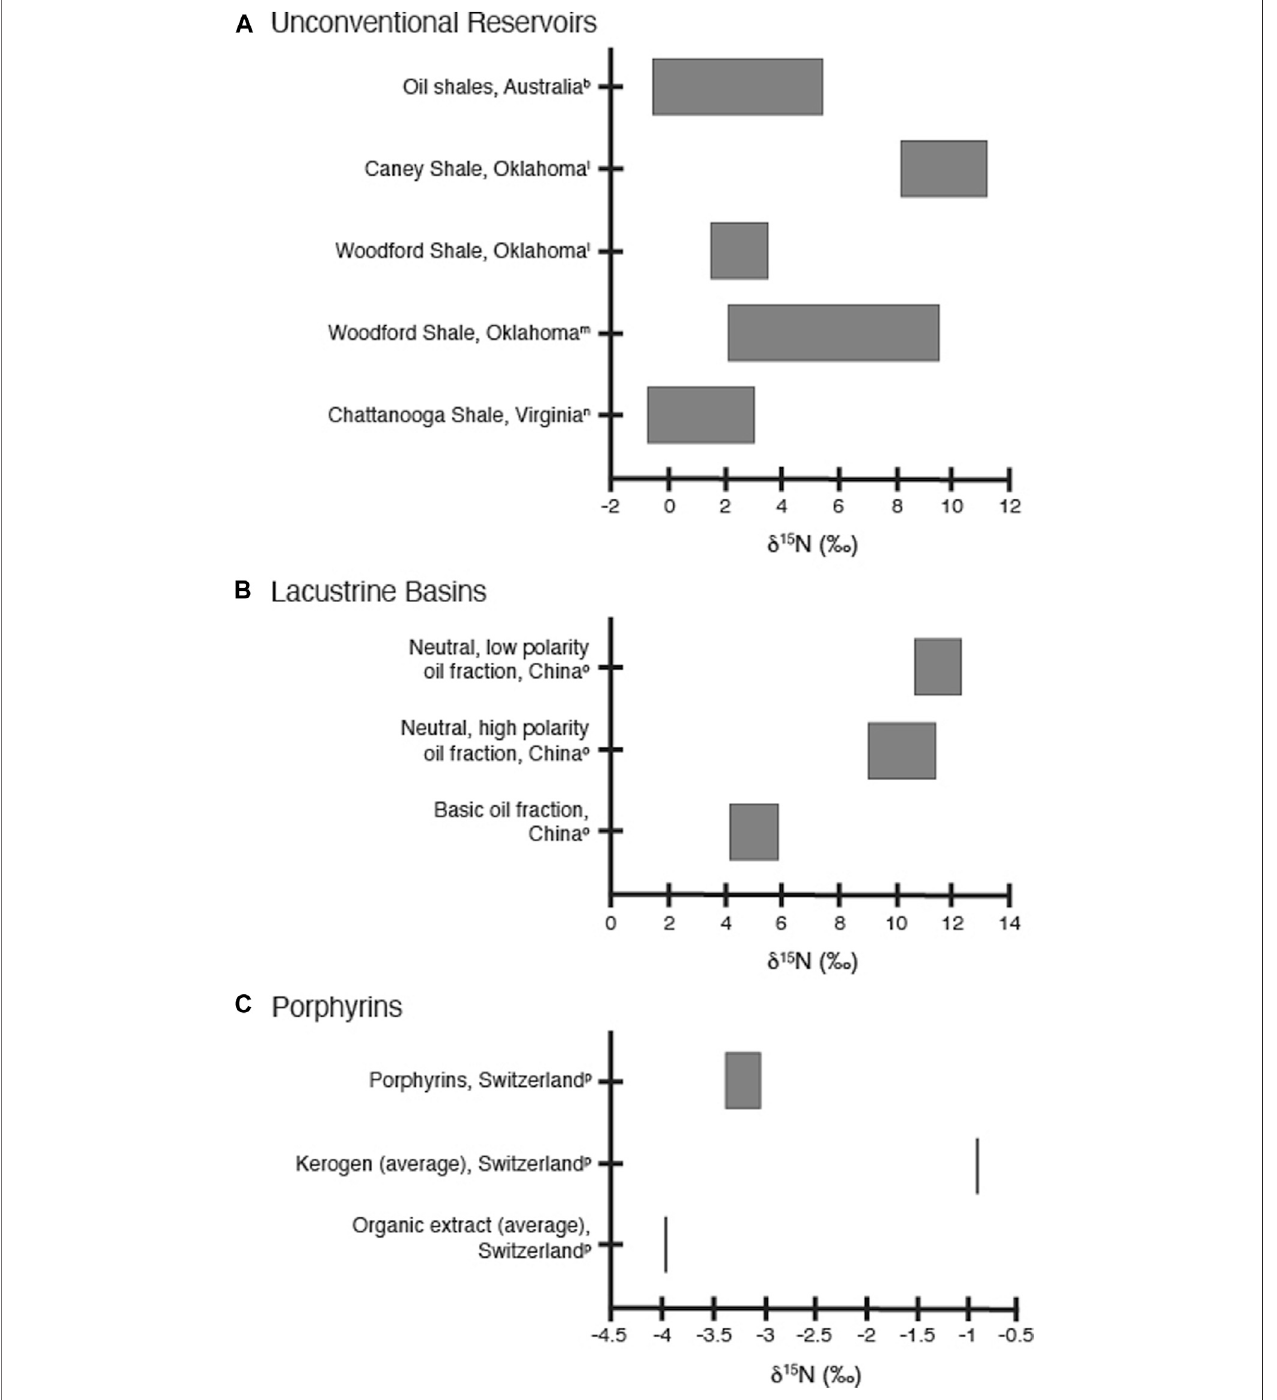
FIGURE 6 | (A) : Ranges of measured δ 15 N values for shale samples from unconventional reservoirs as referred to in the text. Values shown are from b Rigby and Batts 1986, l Quan et al. 2013, m Rivera et al. 2015, and n Tuite et al. 2019; for analytical and sample details, please refer to the original articles. (B) : Ranges of measured δ 15 N values for lacustrine nitrogen fractions as referred to in the text. Values shown are from o Oldenburg et al. 2007; for analytical and sample details, please refer to the original article. (C) : Ranges of measured δ 15 N values for porphyrin, kerogen, and organic extracts as referred to in the text. Values shown are from p Chicarelli et al. 1993; for analytical and sample details, please refer to the original article.